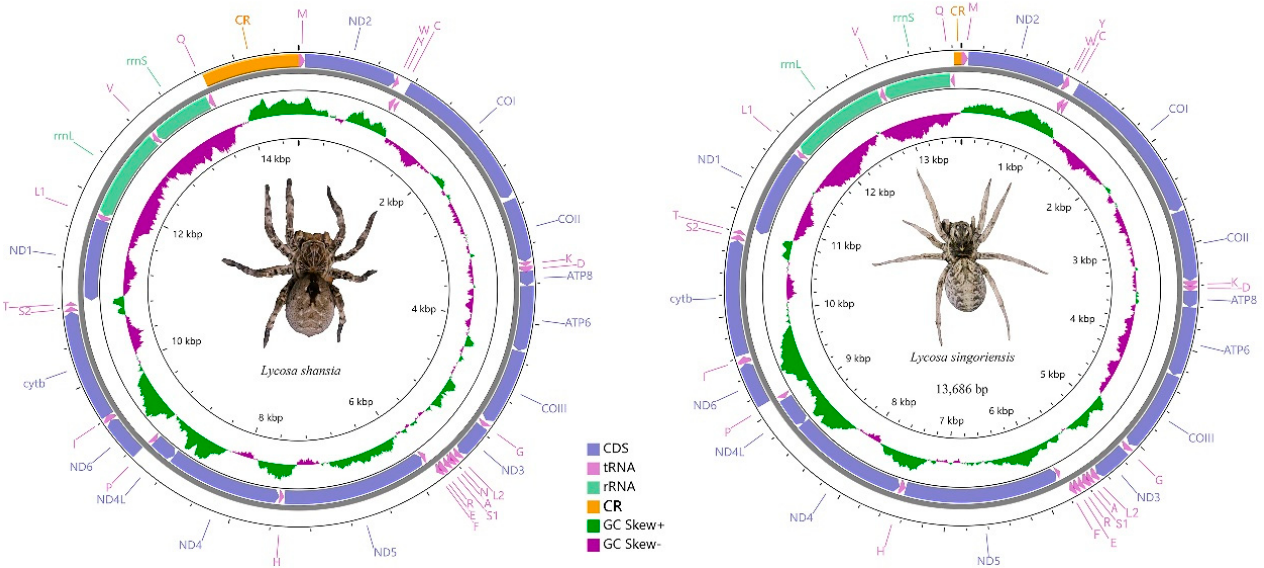
Figure 1. Annotated mitogenomes of L. shansia and L. singoriensis .